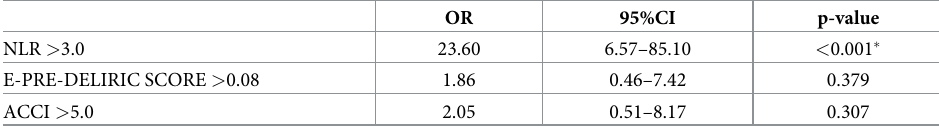
Table 3. Multivariate logistic regression analysis results with three variables. OR 95%CI p-value